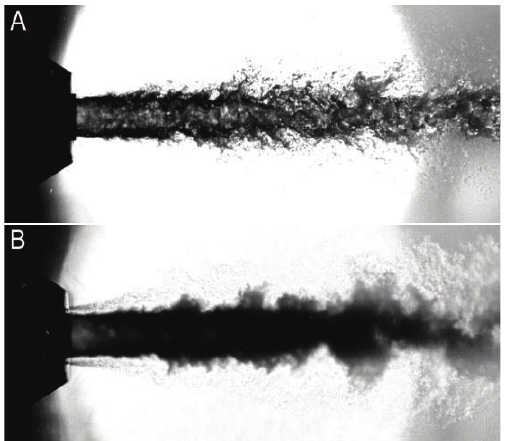
Figure 16: Binary coaxial liquid N 2 / GHe system at (A) chamber pressure of 1.0 MPa, (B) chamber pressure of 6.0 MPa. Inner-tube = 1 . 9mm; liquid nitrogen injection velocity, hole diameter, d LN 2 = 5m / s; helium gas injection velocity, v = 100m / s; v LN He 2 Figure 17: The inner-jet reduced temperature for a coaxial injector = 97K; gaseous helium liquid nitrogen injection temperature, T LN 2 plotted versus the annular outer-jet mass flow rate, normalized by injection temperature, T He = 280K (from Telaar et al. [41]). its maximum mass flow rate, at four di ff erent chamber pressures. Inner-jet mass flow rate is fixed at about 275 mg/s. The lines, called “FIT” on the inset, are curve fits to the raw data. The maximum outer-jet mass flow rates for 1.4, 2.4, 3.5, and 4.8MPa are 2,995, 2,985, 2,974, and 2,918 mg/s, respectively, Davis and Chehroudi